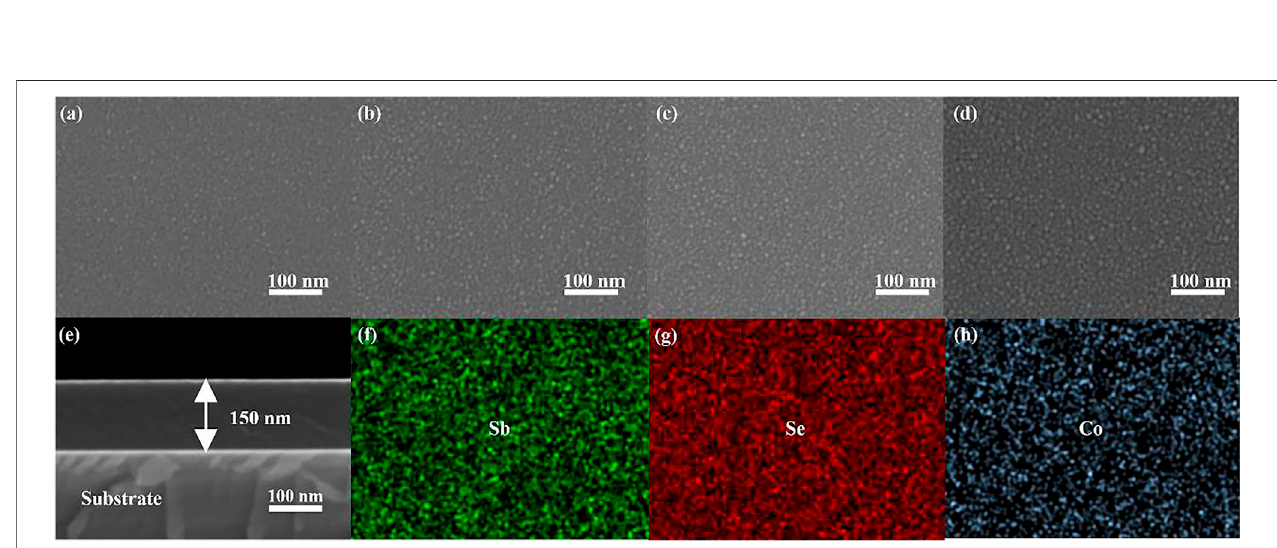
FIGURE 3 | The structures of Sb 2 Se 3 with Co on (I) Sb (II) Se, and (III) interstitial site.